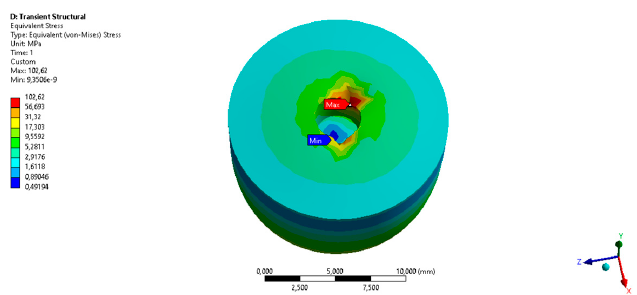
Figure 4. Thermal-Structural Analysis. Equivalent Stress 102.6 MPa.